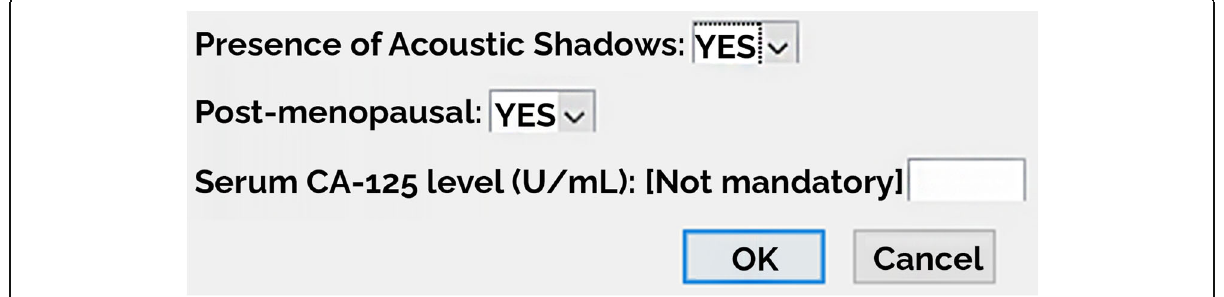
Fig. 3 Interface for supplementary information: presence of acoustic shadows, subject menopausal state, and serum CA-125